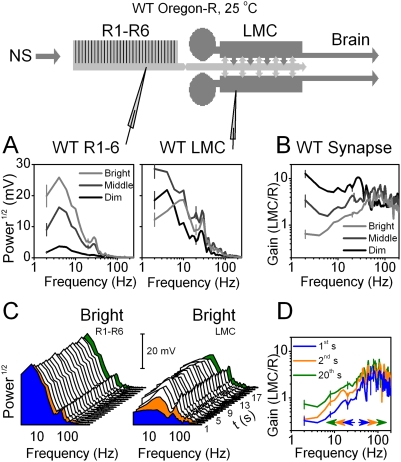
Adaptation shapes frequency spectra dynamically.Frequency spectra of photoreceptor and LMC voltage responses to repeated presentations of naturalistic stimulus, NS, vary with light intensity and over time. A. Mean frequency spectra of seven photoreceptors (left) and a characteristic LMC (right) for the first 20 s of dim, middle and bright stimulation. B. Corresponding synaptic gain changes with light intensity. Notice the progressive removal of low frequency signals with brightening luminance levels. C. Changes in photoreceptor (left) and LMC (right) frequency spectra to the repeated bright stimulus during the first 20 s (1st s = black; 2nd s = red; 20th s = green); adaptation affects mostly LMC frequency spectra in the five first seconds of repeated stimulation. D. Because of the increasing low frequency content (up arrows), synaptic gain spreads more evenly within the bandwidth over time (arrows). Error bars are SD.